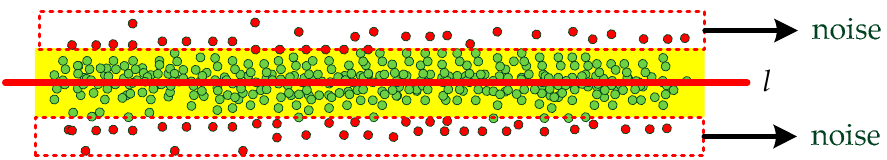
Figure 6. The noise in the points. We need to extract the line l and remove the noise. The radius outlier removal (ROR) [49] filter is an effective tool for noise removal. If the ROR filter is not optimized in any way, this method is very inefficient. Therefore, we use the GROR (grid radius outlier removal) filter to optimize the ROR filter. We mesh the data and then search for the nearest neighbor points in a specific way. The results show that the efficiency of this method is greatly improved without affecting the accuracy of the ROR filter. At the same time, due to the high density of the vertical wall point and the low density of other sundries points after projection, some sundries points are removed by the GROR filter. The principle of this method is shown in Figure 7. x grid { {